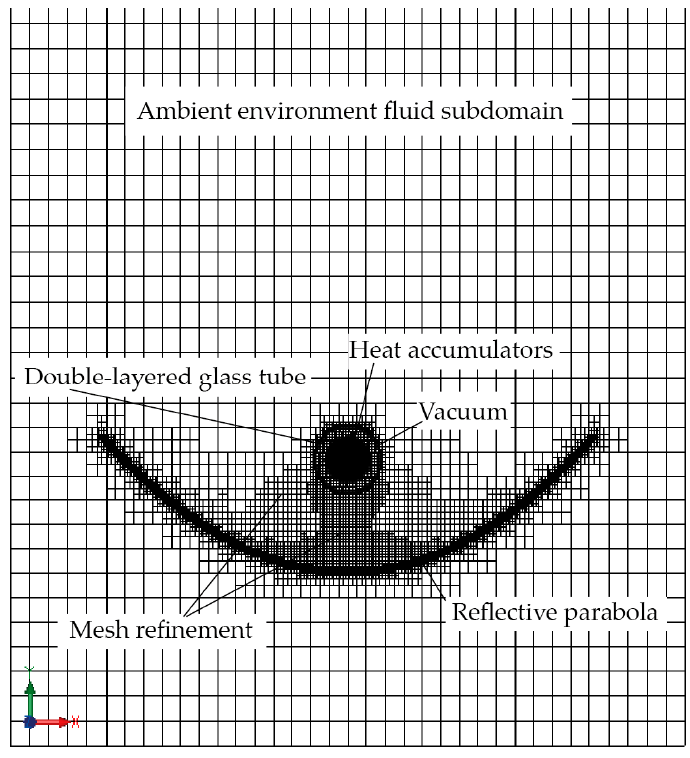
Figure 7. Section-view of meshed model.